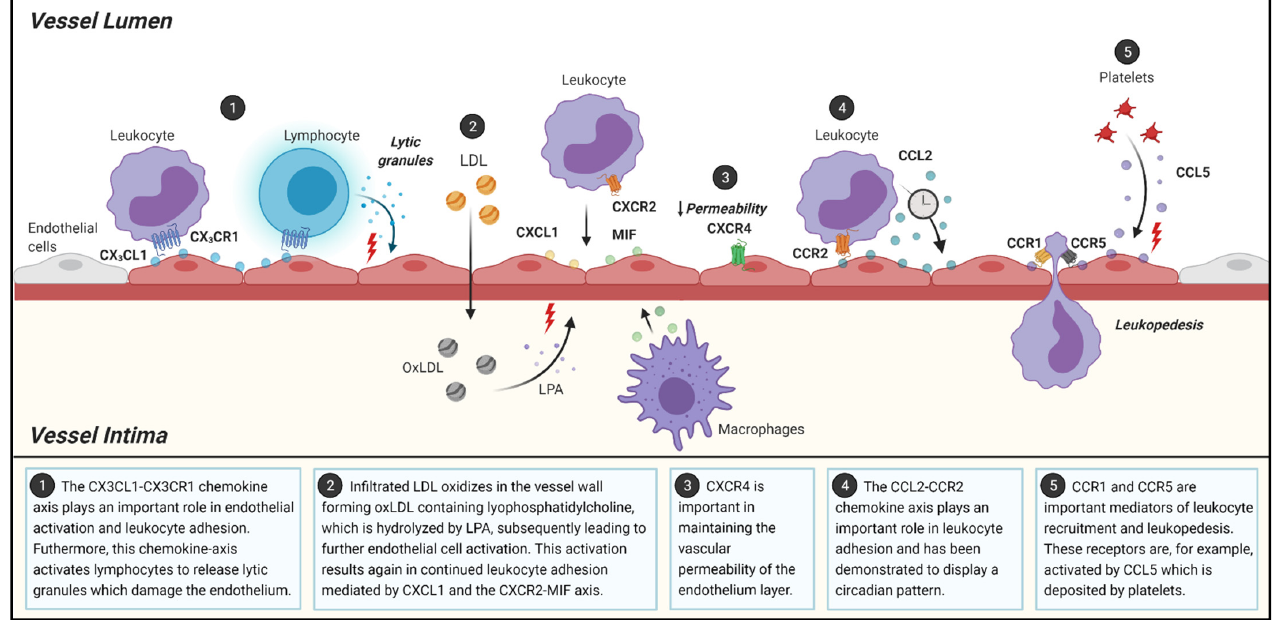
Figure 1. Schematic overview of the role of chemokines and chemokine-receptors in different processes during atherosclerosis initiation. LDL: low density lipoprotein; LPA: lysophosphatidic acid . Figure was created using BioRender.com .